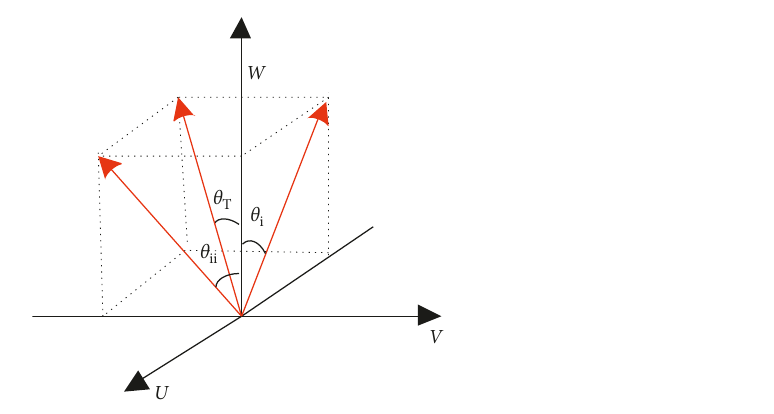
Figure 4: PEs in the UVW coordinate system.